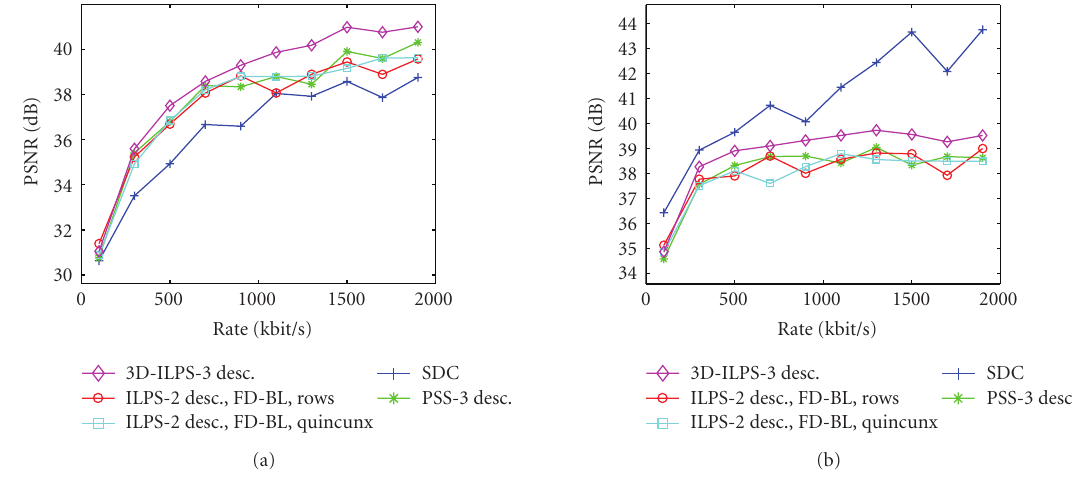
Figure 16: Performance of color view, three subsequences received, 10% packet loss. (a) Breakdance. (b)